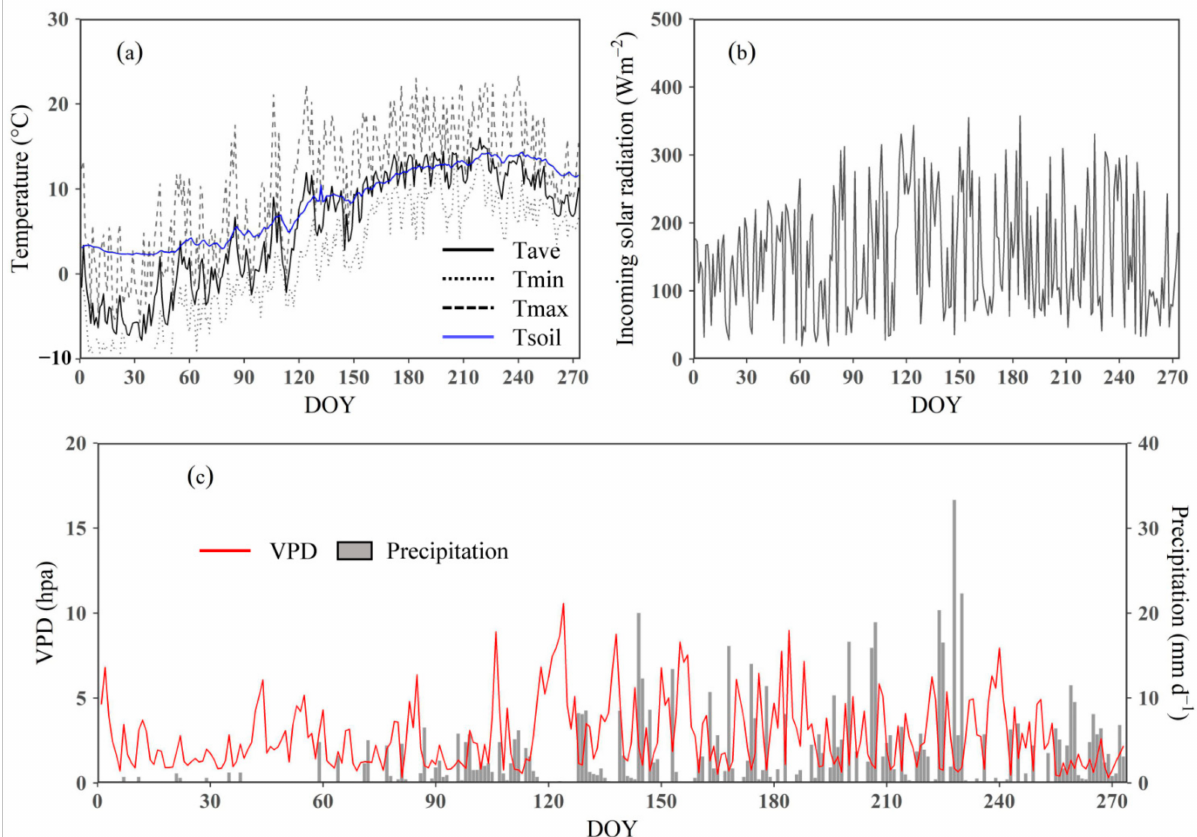
Figure 2. Seasonal variations in daily average air temperature (Tave, a ), daily minimum air temperature (Tmin, a ), daily maximum air temperature (Tmax, a ), daily average soil temperature (Tsoil, a ), daily average incoming solar radiation ( b ), daily average VPD ( c ) and daily precipitation ( c ) over Wanglang Reserve in